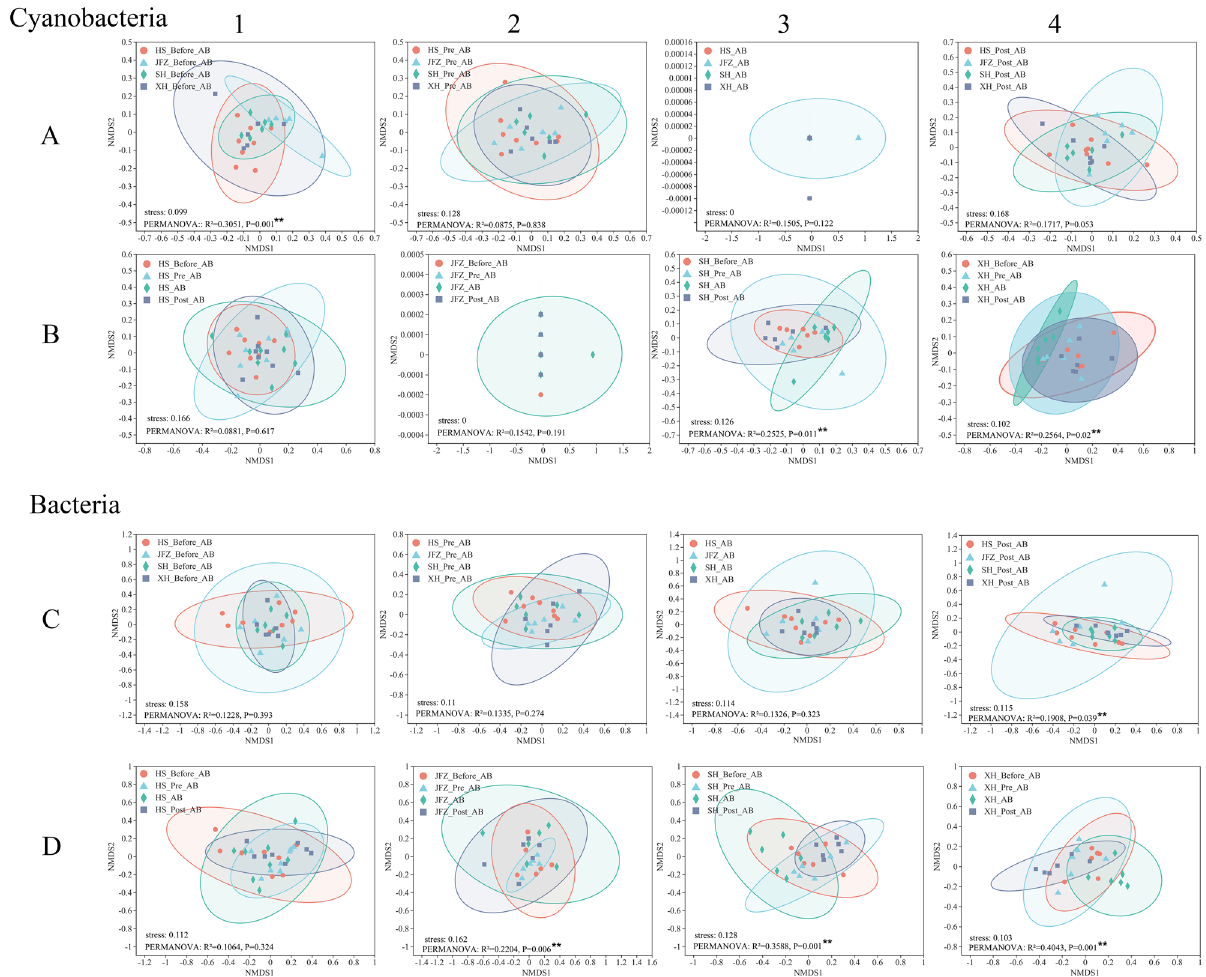
Figure 4. Non-metric multidimensional scaling analysis (NMDS) on cyanobacterial and bacterial communities. Figures of ( A1 – A4 ) presented the difference of cyanobacterial community in different rivers at the same phase, and figures of ( B1 – B4 ) illustrated the difference of cyanobacteria of each river at different phases. Figures of ( C1–C4 ) and ( D1–D4 ) were the bacterial communities equivalent to ( A1 – A4 ) and ( B1 – B4 ) comparisons, respectively. ** indicated the significant level at